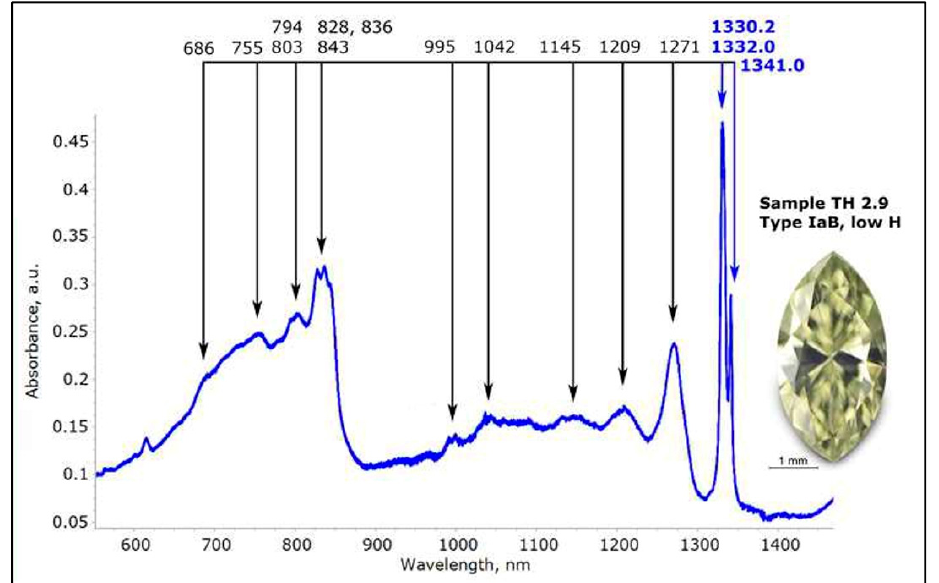
Figure 19. The extended low temperature UV-Vis-NIR spectrum of sample TH 2.9, an almost hydrogen deficient 1330 nm center diamond; the practical absence of hydrogen in the spectra of this diamond demonstrate that the 1330 nm center has no link to hydrogen. The structure seen from 820 to 550 nm is proposed to be an electronic transition to a higher excited state of the defect.